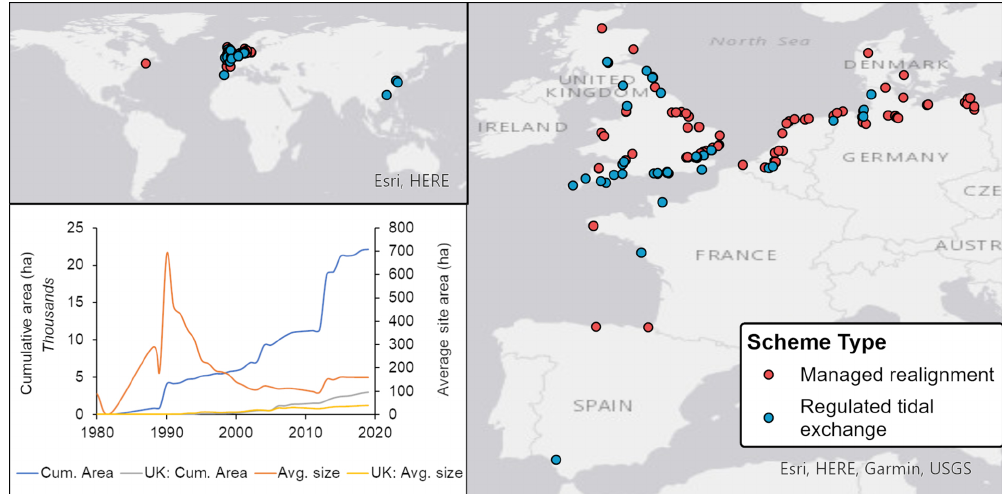
Figure 1. Spatial distribution of managed realignments (red dots) and regulated tidal exchange schemes (blue dots) globally (upper left panel) and in Europe (right panel). Lower left panel: cumulative areas (ha) of coastal managed realignments and regulated tidal exchange globally (blue) and in the UK (grey) and average scheme sizes (ha) for sites globally (orange) and in the UK (yellow). Data source: ABPmer